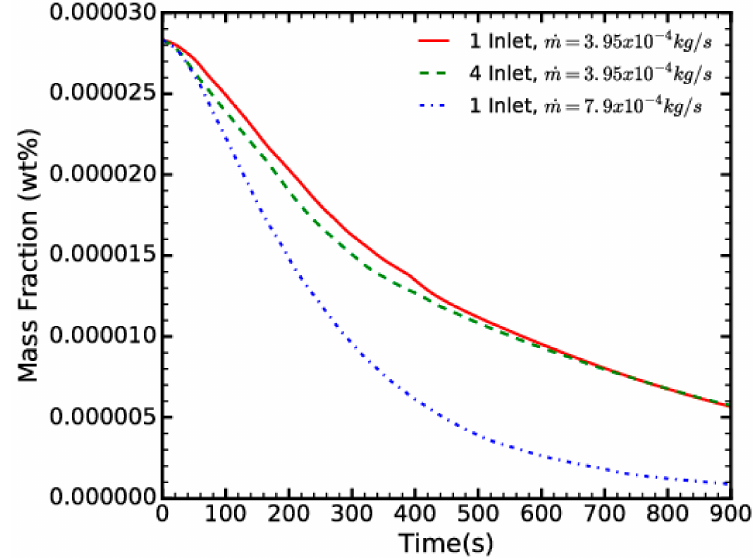
Figure 12. Time evolution of the mass fraction of water in the fuel for the single-inlet and four-inlets with a mass flow rate of 3.95 × 10 − 4 kg/s, and a single-inlet case with the mass flow rate increased by a factor of